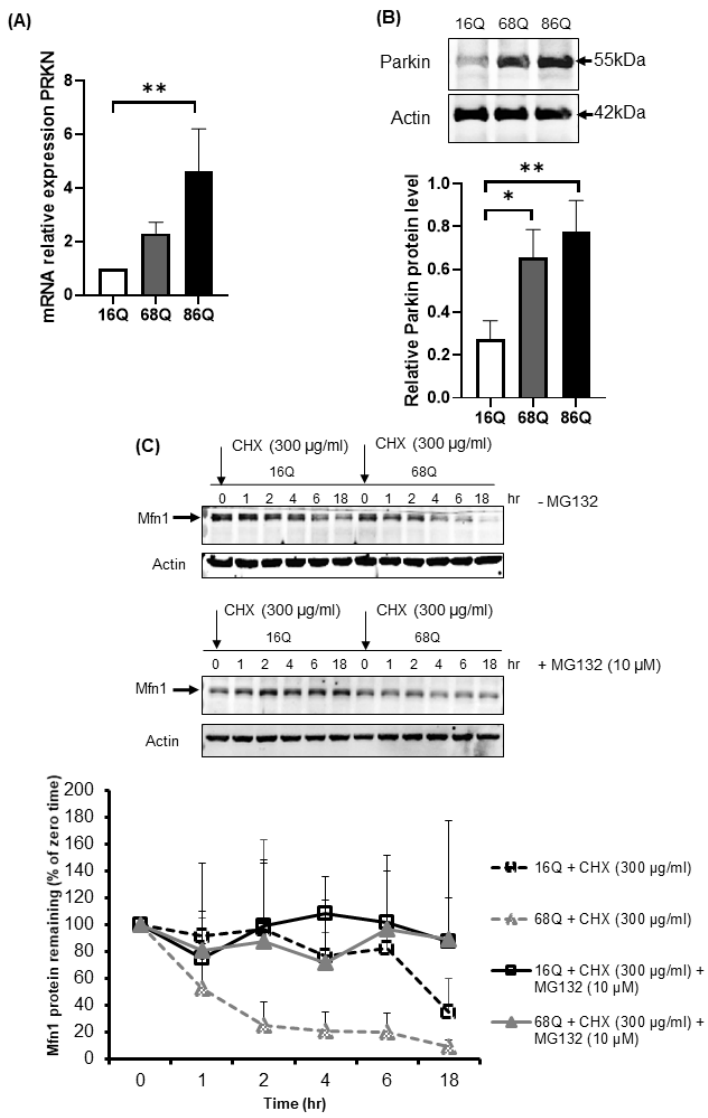
Figure 7. Upregulation of both mRNA and protein levels for parkin in juvenile HD fibroblasts accelerate Mfn1 degradation. ( A ) The mRNA level of PRKN (parkin) was examined by qPCR. The data of mRNA levels of HD (68Q and 86Q) fibroblasts were normalized to the healthy control (16Q). Data are presented as mean values ± SD and represent three independent experiments. Statistical analysis was performed using ANOVA test by GraphPad Prism 8.2.1 (* indicates p < 0.05, ** indicates p < 0.01, *** indicates p < 0.001). ( B ) Equal protein amounts were subjected to SDS-PAGE followed by immunodetection with a Parkin-specific antiserum. Actin was used as loading control. Protein levels in HD (68Q and 86Q) fibroblasts were compared to healthy control (16Q). Data represent the mean ± SD, n = 3 independent experiments (lower panels). Statistical analysis was performed using ANOVA test by GraphPad Prism 8.2.1 (* indicates p < 0.05, ** indicates p < 0.01, *** indicates p < 0.001). ( C ) Mfn1 turnover was determined in healthy and HD fibroblasts in the presence and absence of 10 µ M MG132. New protein synthesis was blocked by 300 µ g / mL CHX. At the time points indicated, cells were harvested and lysed, and equal protein amounts were subjected to SDS-PAGE followed by immunodetection with an Mfn1-specific antibody. Actin was used as loading control (upper panel). Chemiluminescence intensities of the bands in four independent experiments were quantified using the Image Lab software, and corrected for the loading control (actin) (lower panel). Statistical analysis was performed using student t-test by GrapPad Prism 8.2.1 (* indicates p < 0.05, ** indicates p < 0.01, *** indicates p <